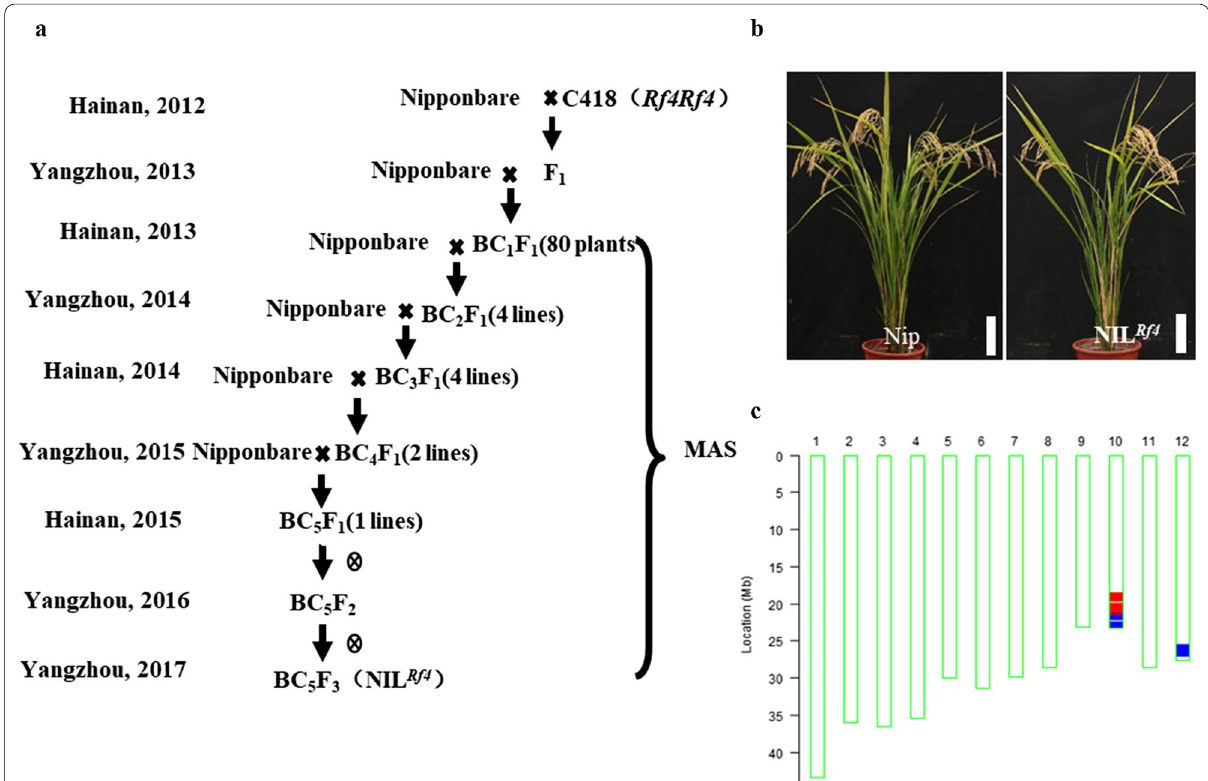
Fig. 3 Breeding scheme and gross plant morphology of the parental line and the newly-developed NIL (near-isogenic line) in the ‘Nipponbare’ genetic background. a Breeding scheme showing the development of NIL Rf4 . b Mature plants of ‘Nipponbare’ and NIL Rf4 . Scale bars Genomic constitution of NIL Rf4 . The red and blue boxes on the chromosomes indicate the introgressed chromosomal segments derived from ‘C418’; the red box represents a region that is homozygous for the C418 genotype, and the blue boxes represent heterozygous regions. The substituted regions on the distal end of Chr. 10 cover the region in which Rf4 is